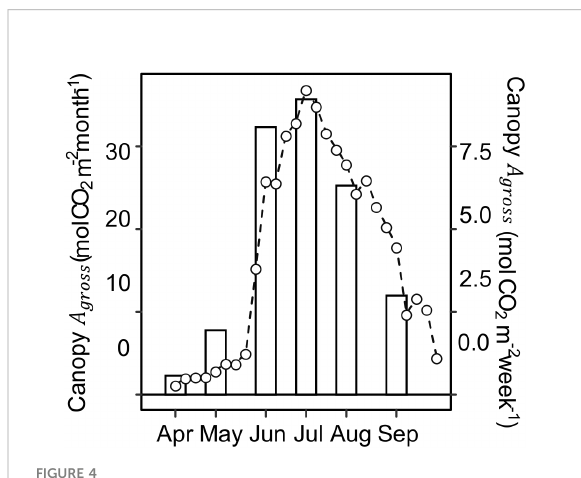
FIGURE 4 Monthly (bars) and weekly (lines and open circles) canopy gross CO 2 assimilation (Canopy A gross ) during the 2020 growing season. Canopy A gross was computed from net ecosystem CO 2 exchange (NEE) observations using eddy covariance method conducted at a switchgrass fi eld of the same age as the experimental site but located 11 km